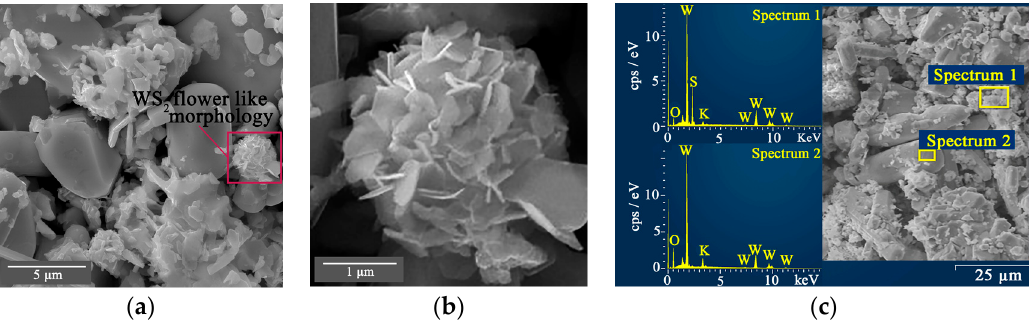
Figure 11. ( a , b ) SEM images and ( c ) EDX spectrum for WS 2 synthesized using WO 3 prepared by USP as precursor.